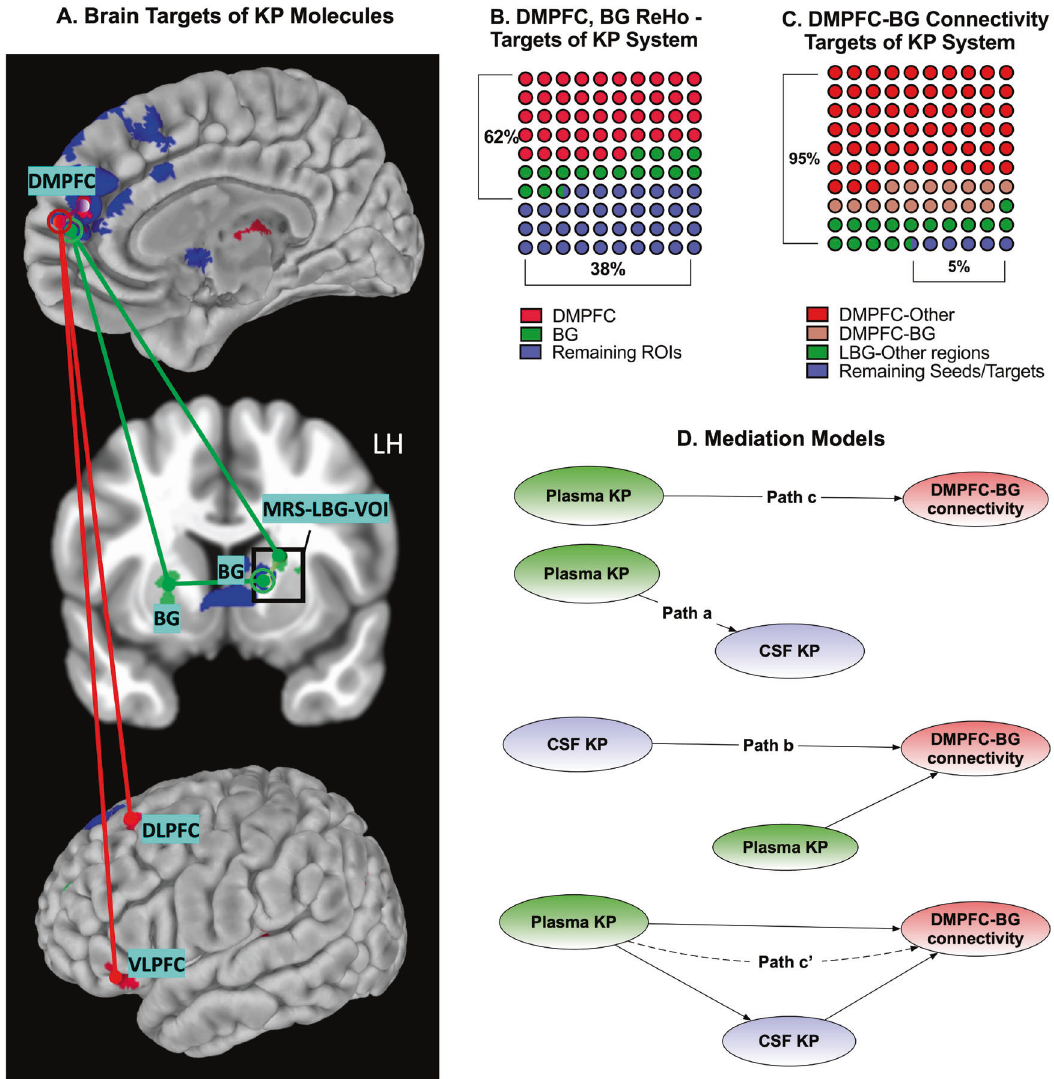
Fig. 2 KP-resting fMRI associations. A presents the primary resting-state functional magnetic resonance imaging (rsMRI) targets of kynurenine pathway (KP) metabolites identi fi ed using voxel-based analysis. The areas shaded in deep blue represent the regions of interest (ROI) that demonstrated altered regional homogeneity (ReHo) associated with plasma or cerebrospinal fl uid (CSF) KP. Identi fi cation of ROIs was based on the correlation between kynurenine (KYN) or 3-hydroxykynurenine (3HK) in either the plasma or CSF. A detailed description of all ReHo seed-ROIs thus derived (total = 12 seeds) is presented in Supplementary Information 4. ROIs correlated with plasma KP are illustrated using red circles and CSF KP-related ROIs are illustrated using green circles. These ROIs were also set as the seeds in seed-to-whole-brain connectivity analysis. The red or green lines and the red or green uncircled dots represent the connectivity and targets, respectively. Connectivity z -scores correlated with plasma and CSF KP measures were derived after controlling for multiple comparisons (threshold = voxel p < 0.001, cluster p < 0.05). B presents a 10 × 10 dot plot depicting the region-wise distribution of voxels (measured using voxel volume = 1 cubic millimeter/voxel), demonstrating ReHo decreases. As is evident, 62% of voxels demonstrating decreased ReHo were located either in the dorsomedial prefrontal cortex (DMPFC), left (LBG), or right basal ganglia (RBG) regions, respectively. C demonstrates a similar dot plot demonstrating the distribution of KP-correlated connectivity disruptions between ReHo seed regions and other brain regions. As is evident, 95% of whole-brain connectivity decreases were associated with DMPFC-BG regions. D represents the overall plan of the path/mediation analyses. Plasma and CSF KP latent factors represent the individual contribution of kynurenine (KYN), 3-hydroxykynurenine (3HK) to each of these factors. DMPFC-basal ganglia (BG) latent factor comprises four different connectivities (DMPFC-LBG, DMPFC-RBG, LBG-LBG, and LBG- RBG). Path c examines the relationship between plasma KP and DMPFC-BG connectivity and Path a examines the association between plasma and CSF KP to each other. Path b examines if plasma KP impacts the association between CSF KP and DMPFC-BG connectivity. Path c ′ presents the model testing mediation by CSF KP of the relationship between plasma KP on DMPFC-BG